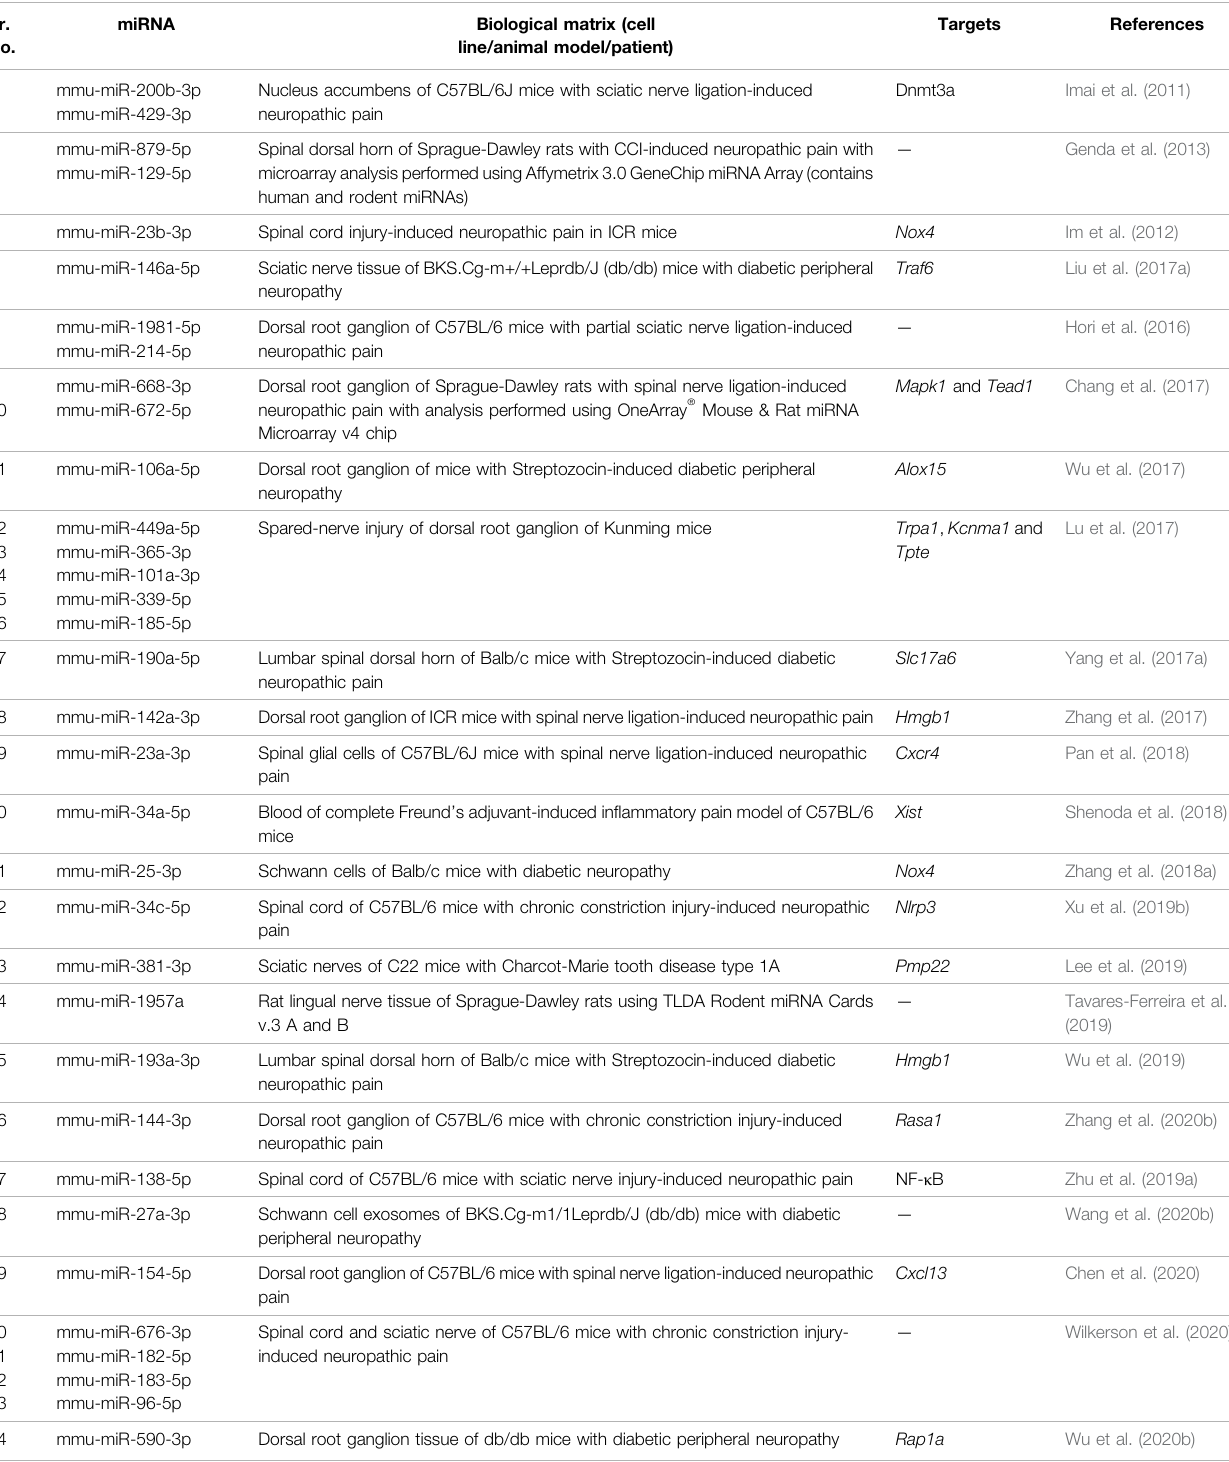
line/animal model/patient)